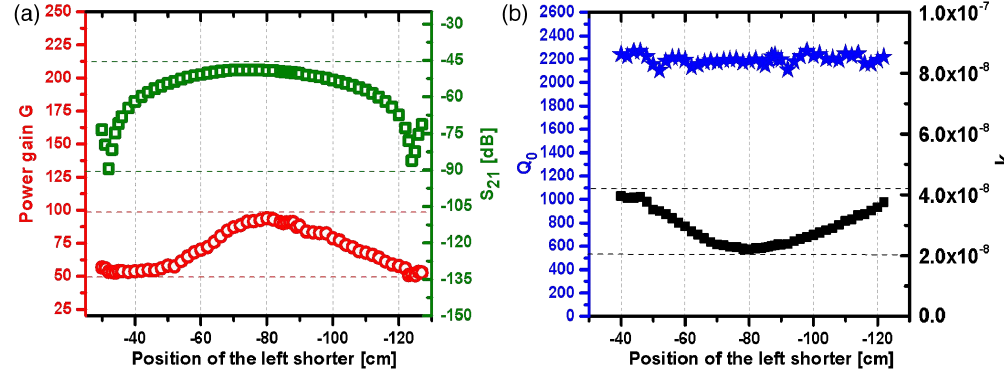
FIG. 18. Low-power test results of the proof-of-principle structure for the test system. (a) shows the power gain and S 21 parameter within the entire moving range of the system, and (b) gives the Q 0 and k of the system.